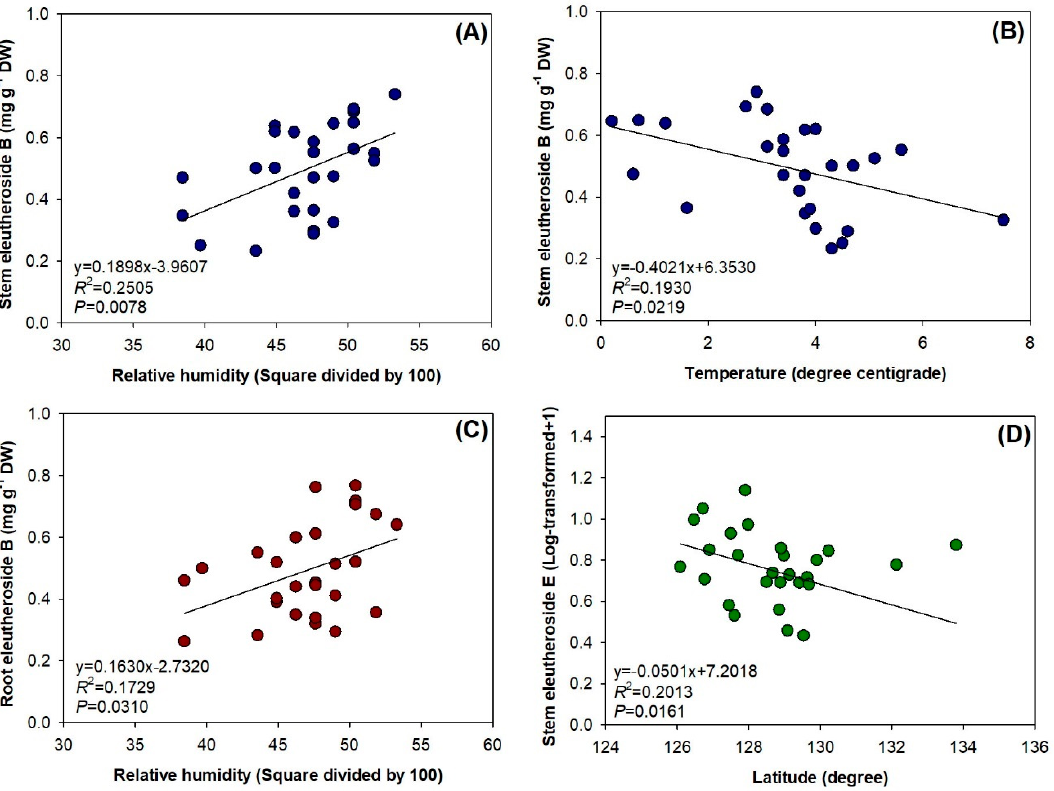
Figure 6. Linear correlation between abiotic factors and concentrations of bioactive compounds in Eleutherococcus senticosus individuals from populations in Northeast China. ( A ) Regression between relative humidity and shoot eleutheroside B concentration; ( B ) regression between temperature and shoot eleutheroside B concentration; ( C ) regression between relative humidity and root eleutheroside B concentration; ( D ) regression between latitude and shoot eleutheroside E concentration. R 2 and P values are coe ffi cients from linear regression models.